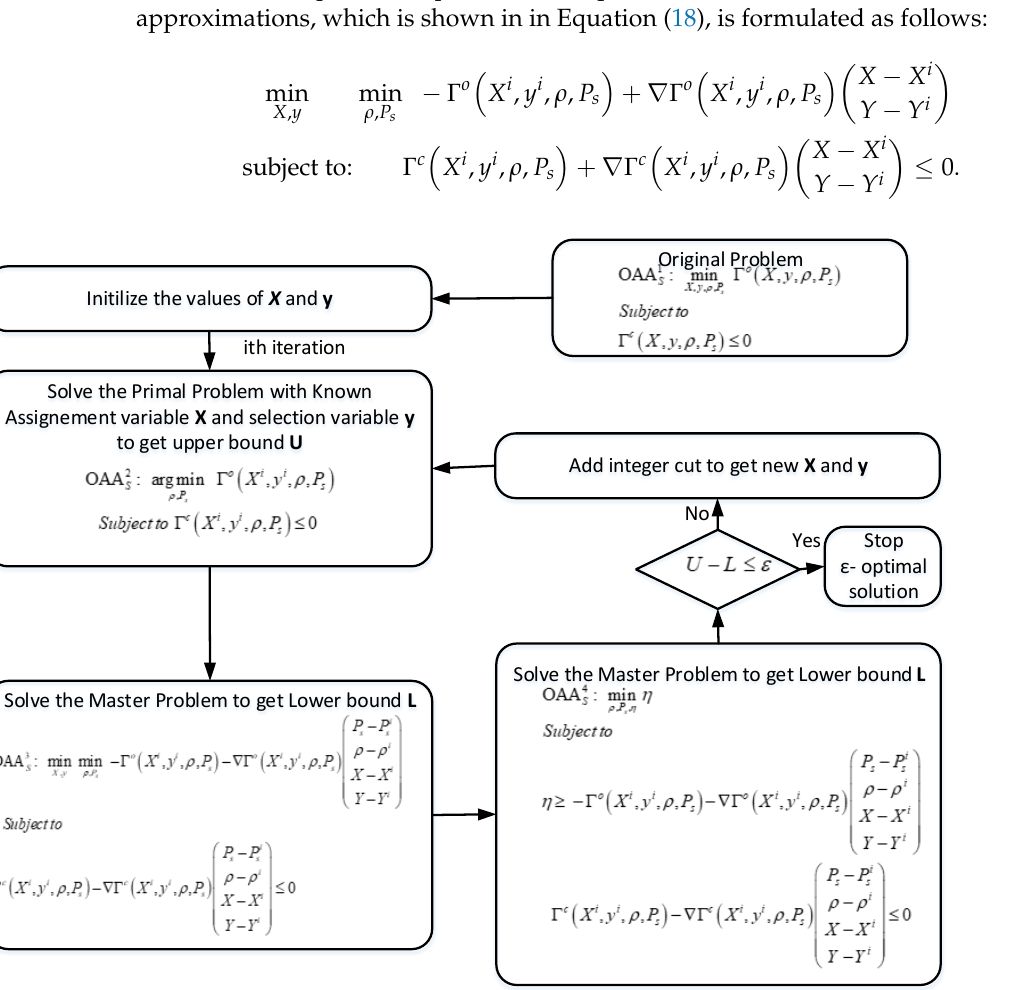
Figure 4. OAA flow